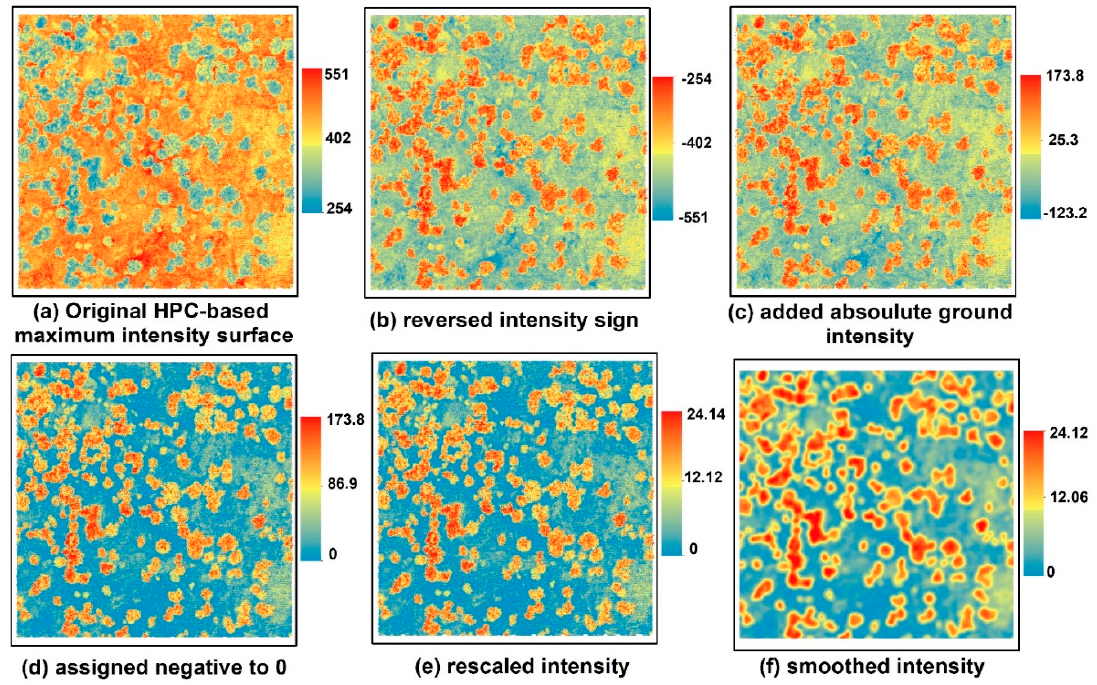
Figure 6. An example of rescaling original HPC-based maximum intensity surface to generate a CHM- like surface. a CHM-like